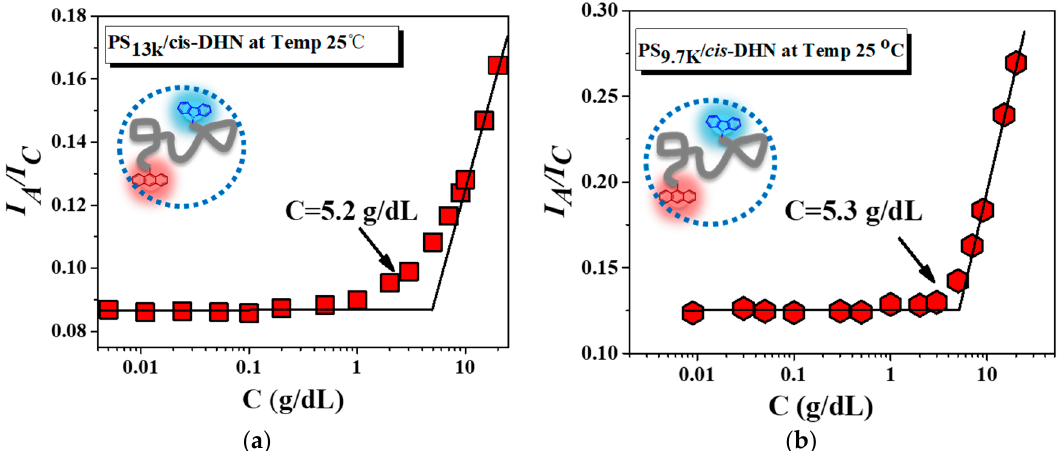
Figure 3. The I A / I C value as a function of concentration for ( a ) Cz-PS 13K -An and PS and ( b ) An-PS 9.7K -Cz and PS in DHN at 25 °C.